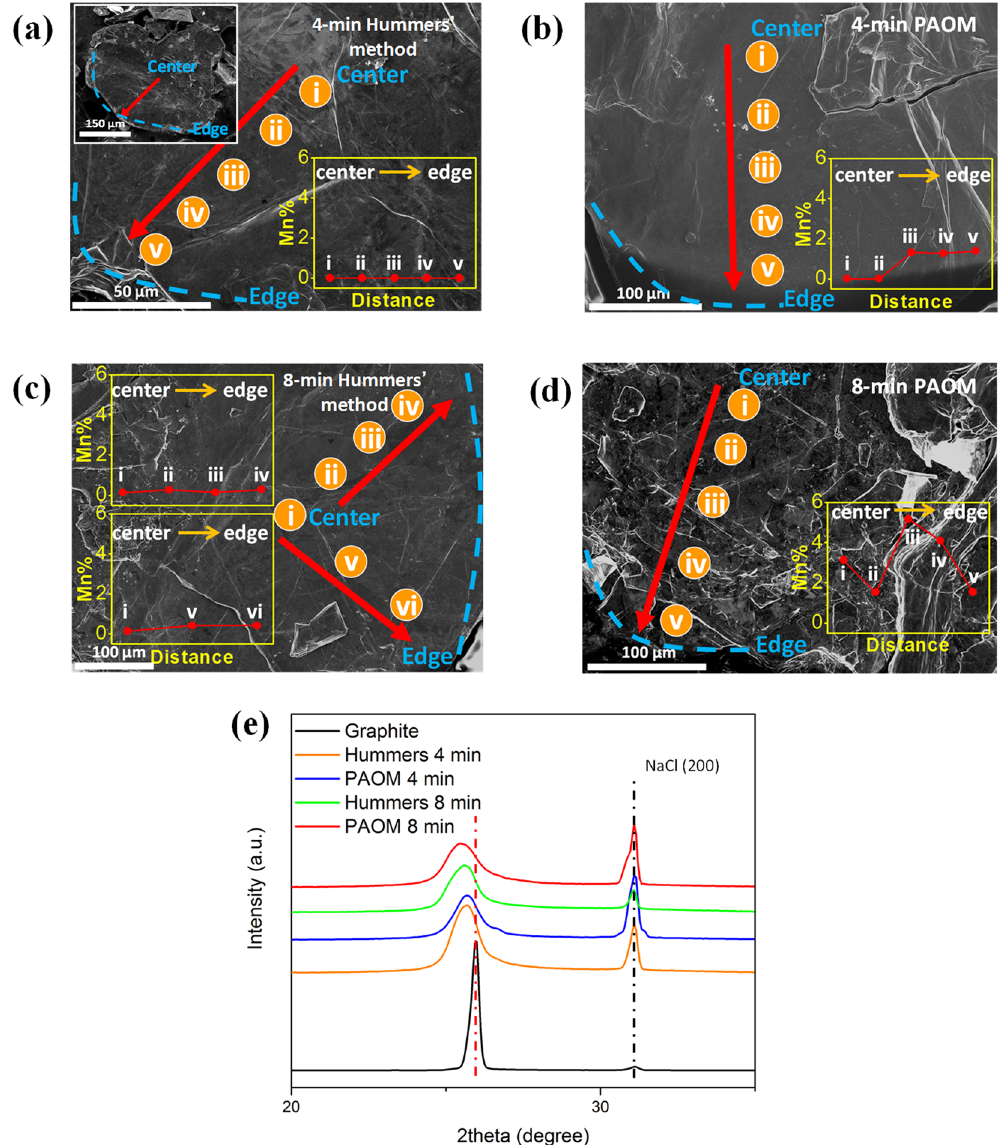
Figure 2. The extent of Mn-oxidant diffusion monitored by EDS in the partially reacted graphite by PAOM and conventional Hummers’ method. The red-arrows indicate the direction from the center toward outer edge (the blue dash-lines) of the individual graphite flake, as shown in the inset of ( a ). The Mn contents are normalized by carbon and summarized in the insets. ( e ) The XRD patterns of the partially reacted samples in ( a )–( d ) and pristine graphite. NaCl is the internal